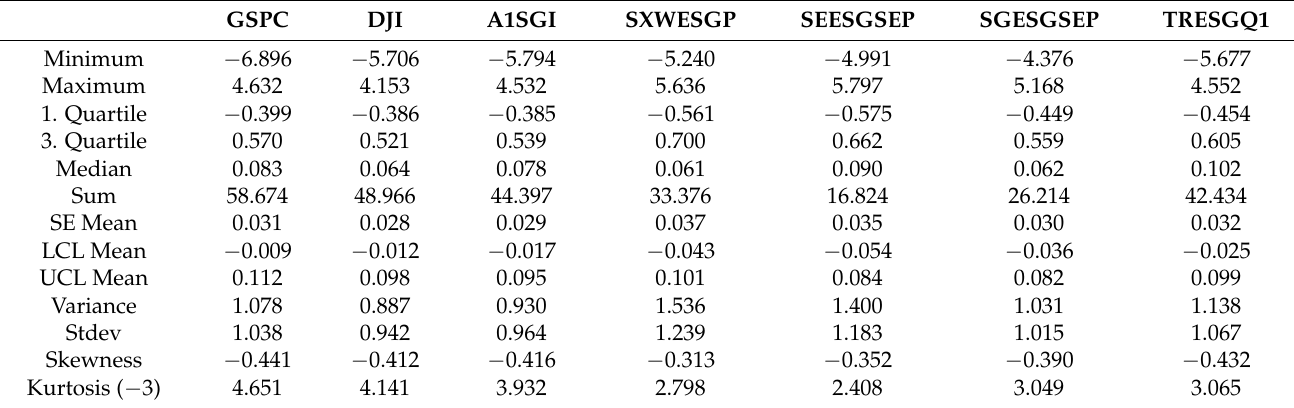
Table 4. Descriptive statistics, 2 December 2009–30 July